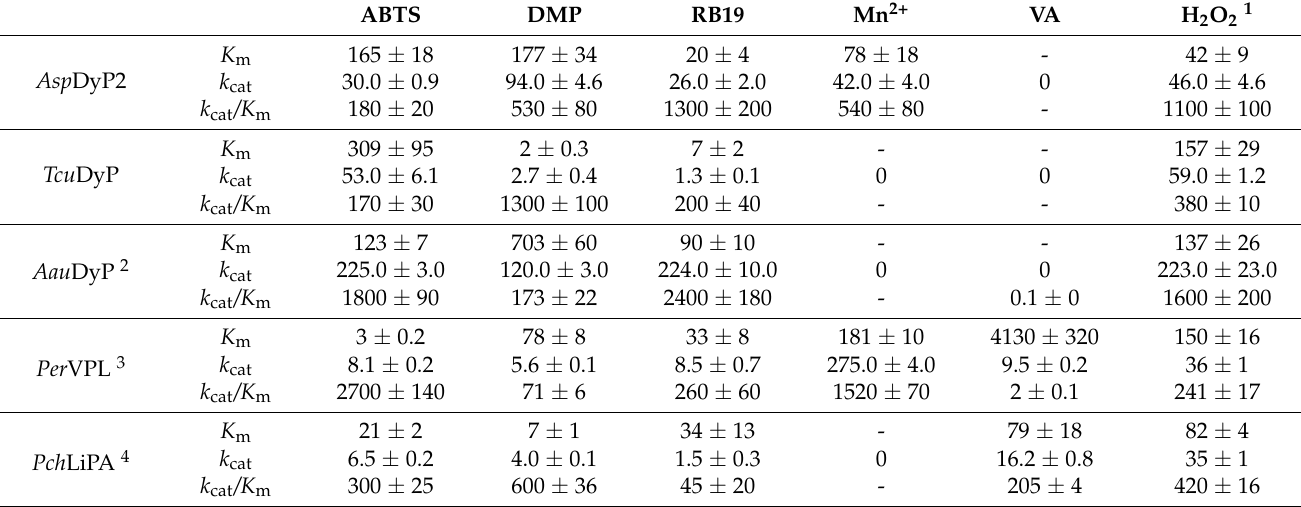
Table 1. Steady-state kinetic parameters − K m ( µ M), k cat (s − 1 ) and k cat / K m (s − 1 · mM − 1 ) − for ABTS, DMP, RB19, Mn 2+ , VA and H 2 O 2 reactions of the bacterial Asp DyP2 and Tcu DyP, obtained here, compared with fungal Aau DyP, Per VPL and Pch LiPA from previous